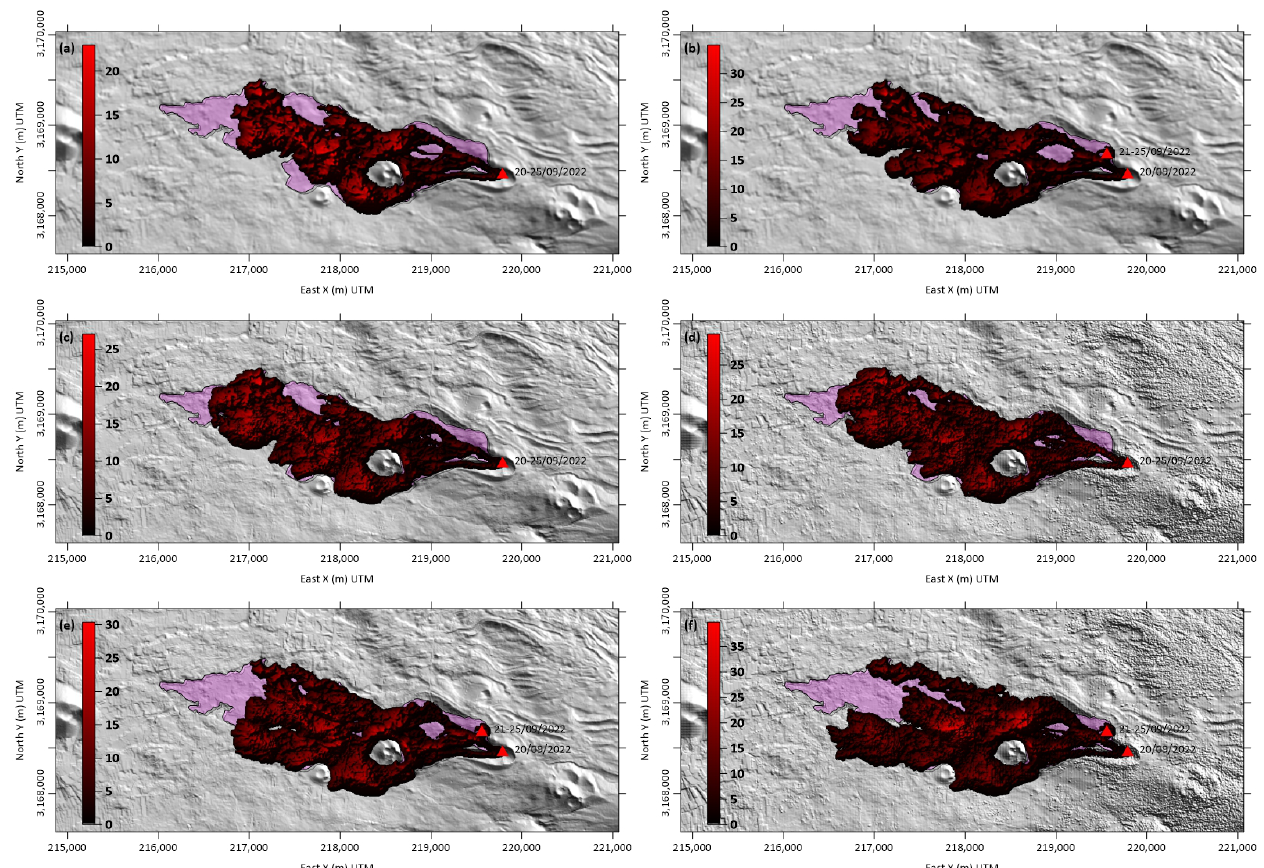
Figure 7. Representation of the lava emplacement on 25 September (in pink) and the one obtained from the simulations (Table 2) carried out up to that day: ( a ) SS1, ( b ) SS2, ( c ) SS3, ( d ) SS4, and ( e ) SS5, and ( f ) SS6. Values in colour legend are lava thicknesses in metres. The background image shown in each figure corresponds to the DEM or DSM used for each simulation scenario.